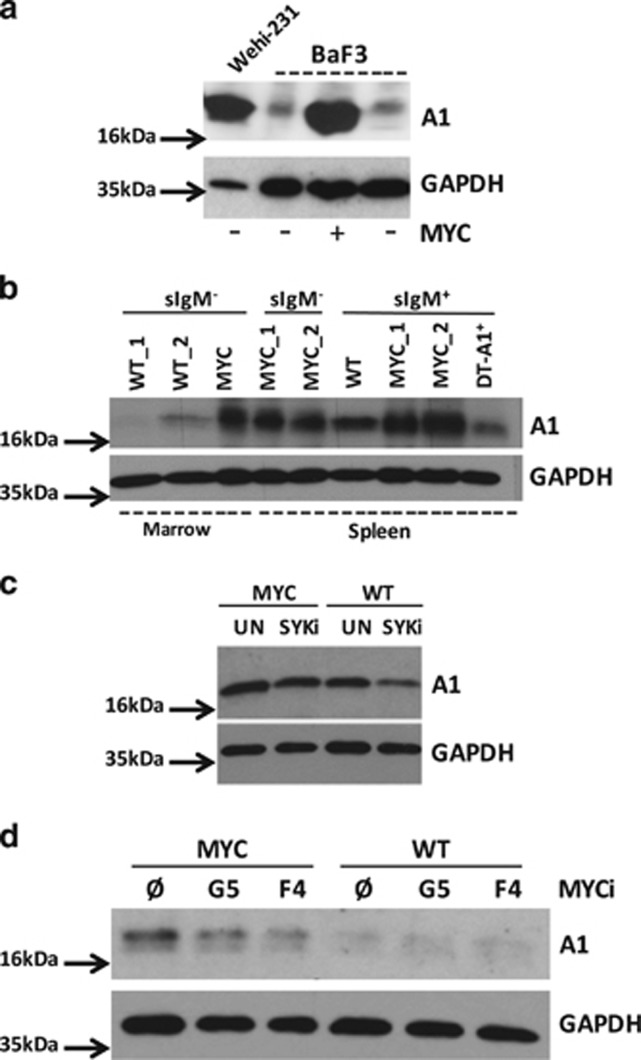
Deregulated MYC expression increases A1 protein levels. A1 protein level was assessed in (a) parental BaF3 mouse pro-B cells and in cells stably transformed with c-MYC or empty vector (EV). (b) Sorted bone marrow or splenic B220+ sIgM+ or sIgM− B cells derived from wild-type and premalignant Eμ-MYC or DT-A1 transgenic mice 4–6 weeks of age were assessed for A1 expression by immunoblot. Figure displays biological replicates; one out of two independent experiments is shown. (c) Expression of A1 in sorted B220+ splenocytes from Eμ-MYC or wild-type mice cultured for 4 h in the absence or presence of 5 μM R406 (SYK inhibitor). One out of two experiments is shown. (d) Sorted IgM+B220+ splenocytes from Eμ-MYC or wild-type mice were cultured for 16 h in the absence or presence of MYC inhibitors 10074-G5 (G5) or 10058-F4 (F4), 25 μM each. Membranes were reprobed for GAPDH to control for protein loading. Figure displays one out of two independent experiments.